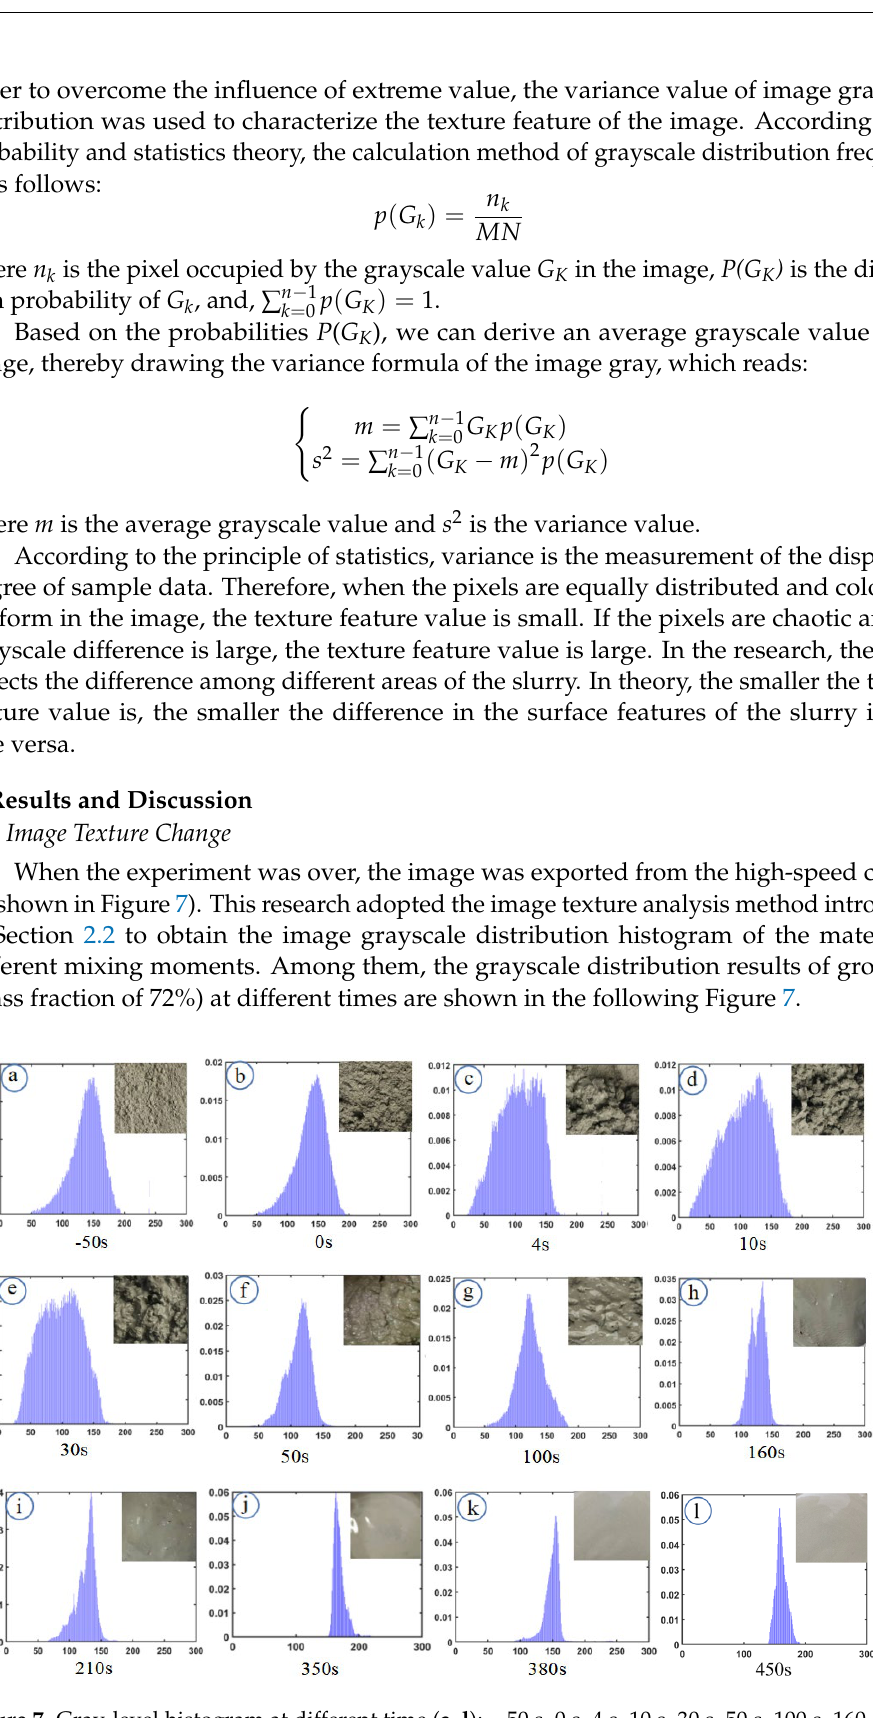
Figure 7. Gray-level histogram at different time ( a – l ); − 50 s, 0 s, 4 s, 10 s, 30 s, 50 s, 100 s, 160 s, 210 s, 350 s, 380 s, 450 s) of a CPB